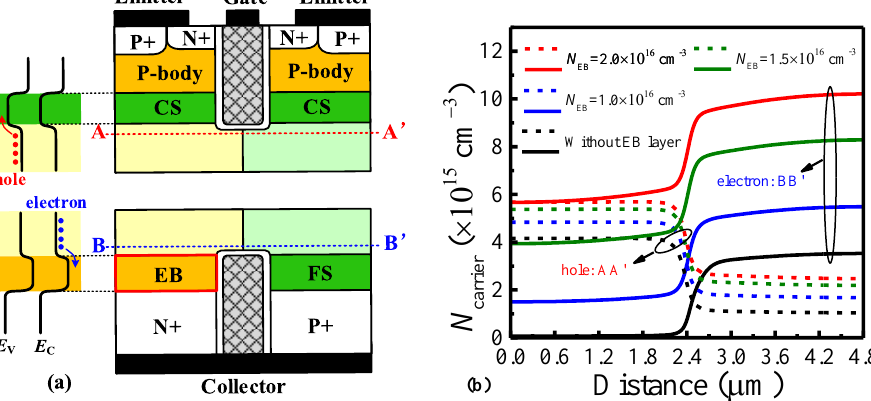
Figure 2. The effect of N EB on carrier distribution. ( a ) Diagram of carrier-storage effect along cut lines position. ( b ) The influence of N EB on hole concentration in the vicinity of CS layer and electron concentration in the vicinity of EB layer at the condition of V G = 15 V and V CE = 1 V.